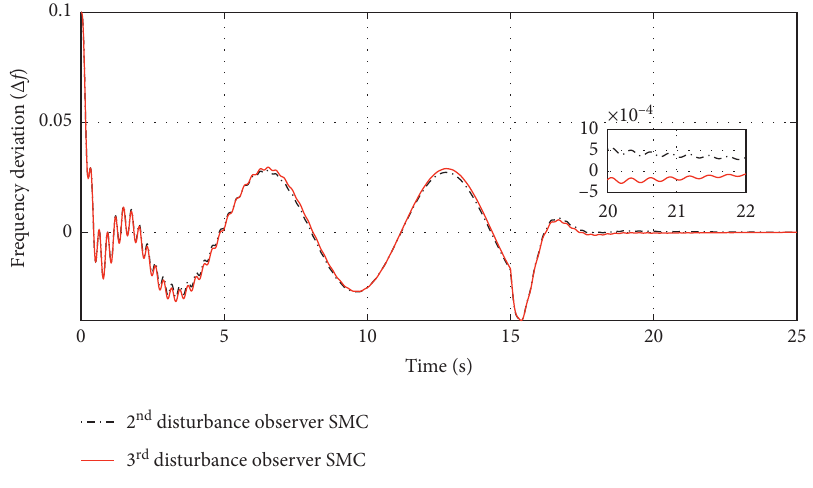
Figure 5: Frequency deviation with the disturbance observer.